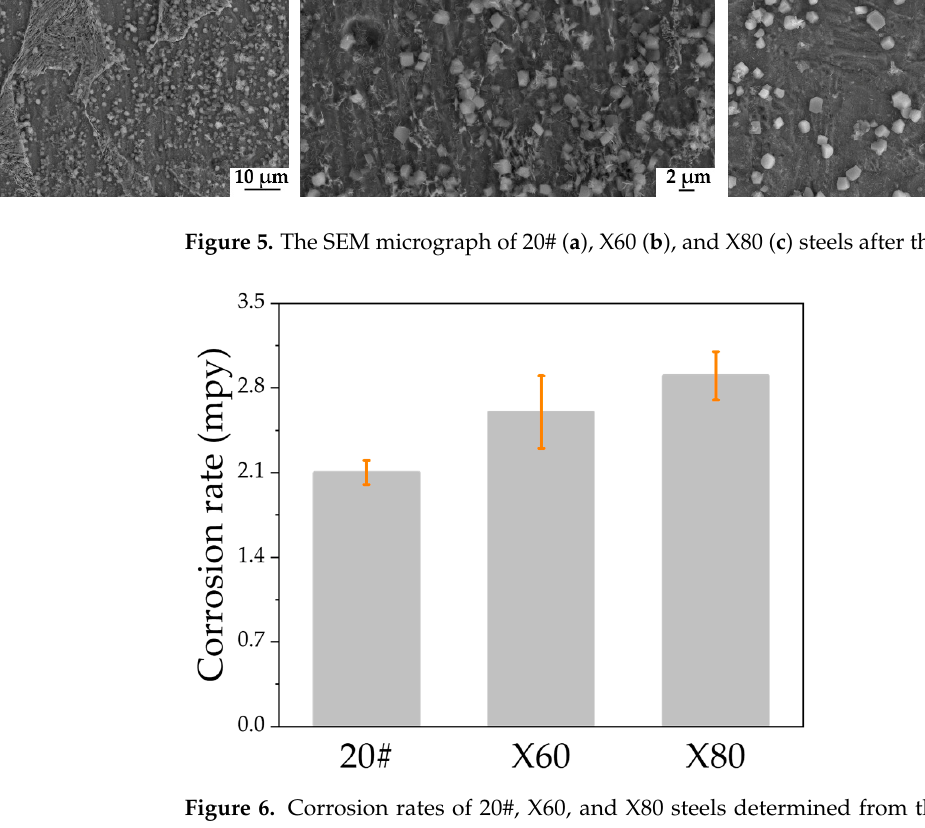
Figure 5. The SEM micrograph of 20# ( a ), X60 ( b ), and X80 ( c ) steels after the polarization test. Table 2. Electrochemical parameters of 20#, X60, and X80 steels in NS4 solution.